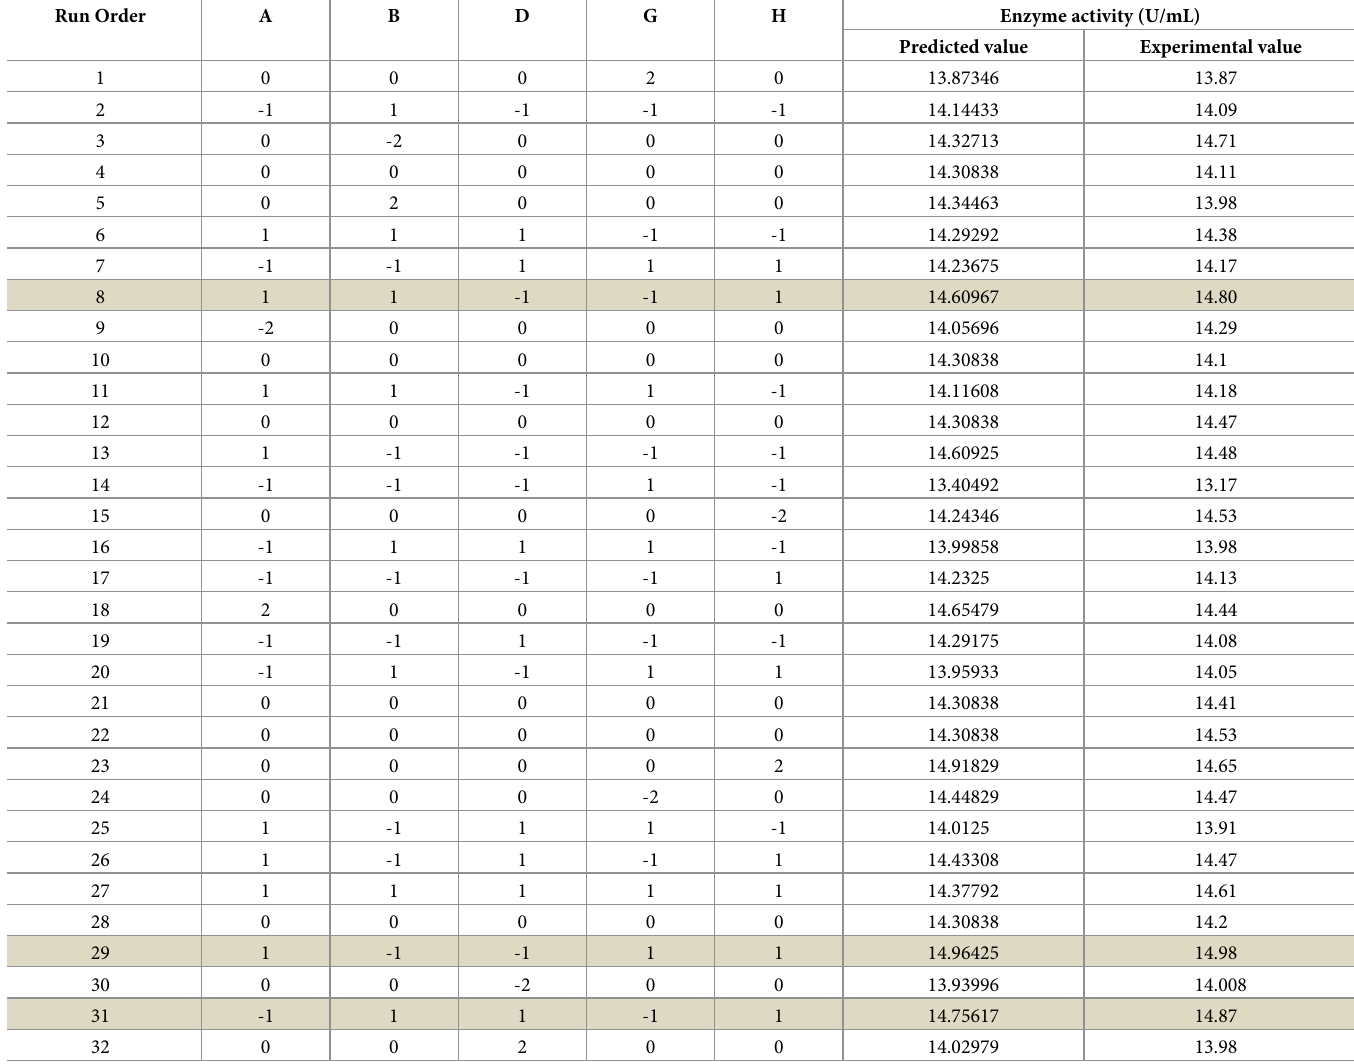
Table 10. Central Composite Design for PHB depolymerase production with the bacterial strain Aeromonas caviae Kuk1-(34)